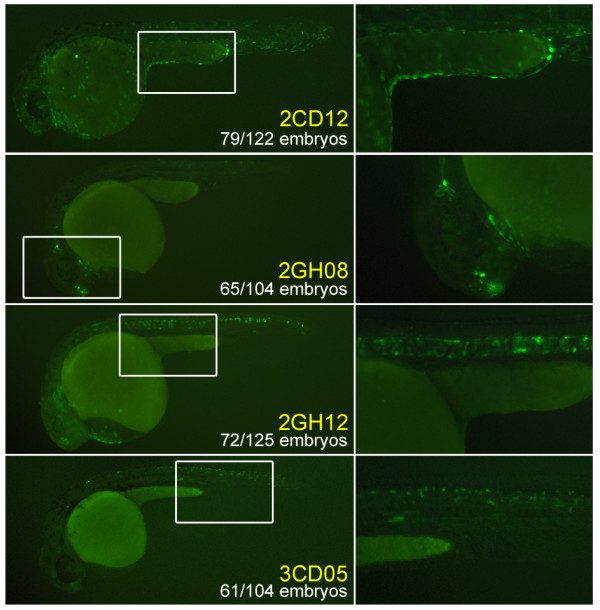
The four uncorrelated constructs chosen for follow-up experiments due to their consistent, specific expression patterns: 2CD12/epidermis; 2GH08/brain (showing both forebrain and otic lateral line expression); 2GH12/notochord; 3CD05/spinal cord. White rectangles indicate regions that are magnified in the right side panels.